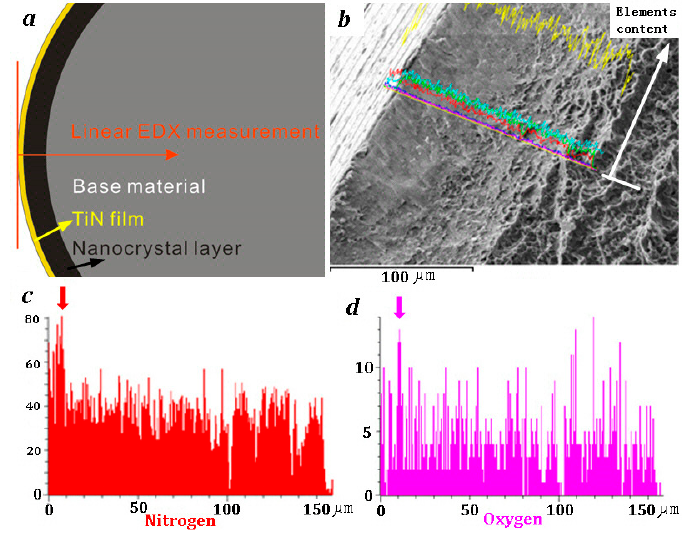
Figure 5. Analysis of TiN film on UNSMed specimen: ( a ) Illustration of measurement; ( b ) Measurement results (yellow curve is Titanium); ( c ) Variation of nitrogen; ( d ) Variation of oxygen.